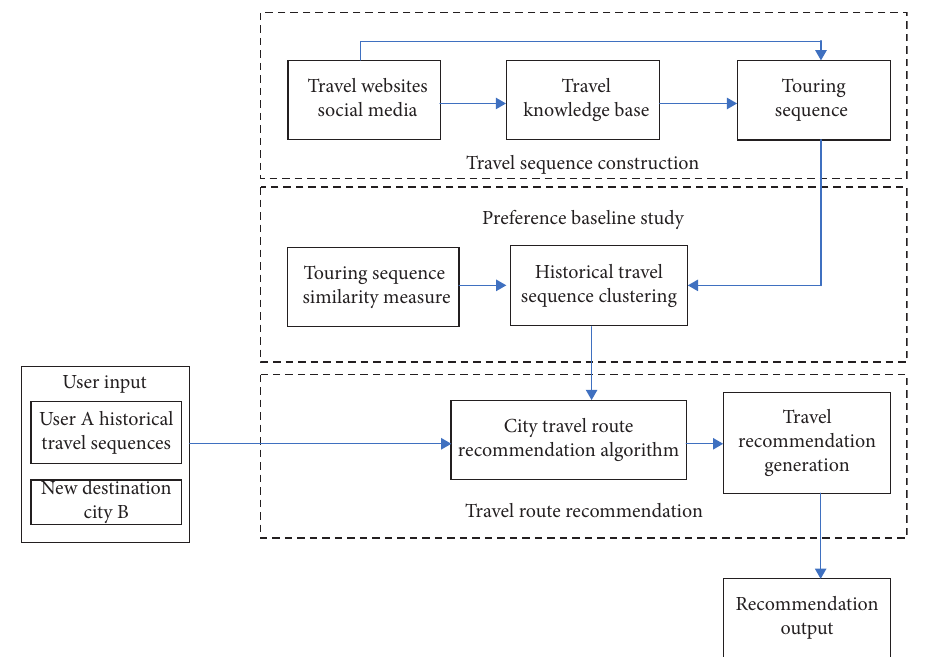
Figure 1: City travel route recommendation